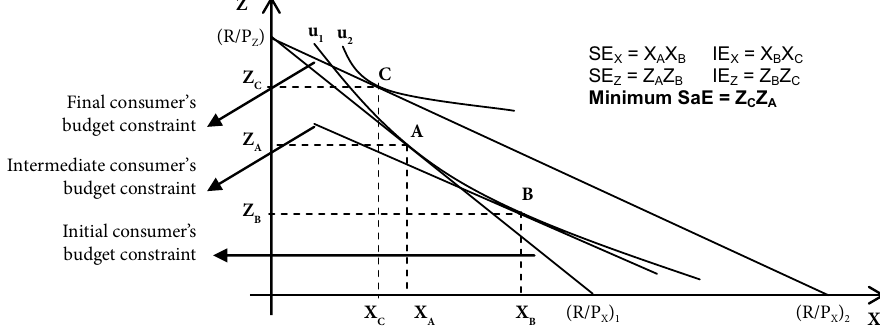
Fig. 2. Graphical representation according to the Hicks’ classical view of the Saving Effect when there are two inferior goods and P falls X